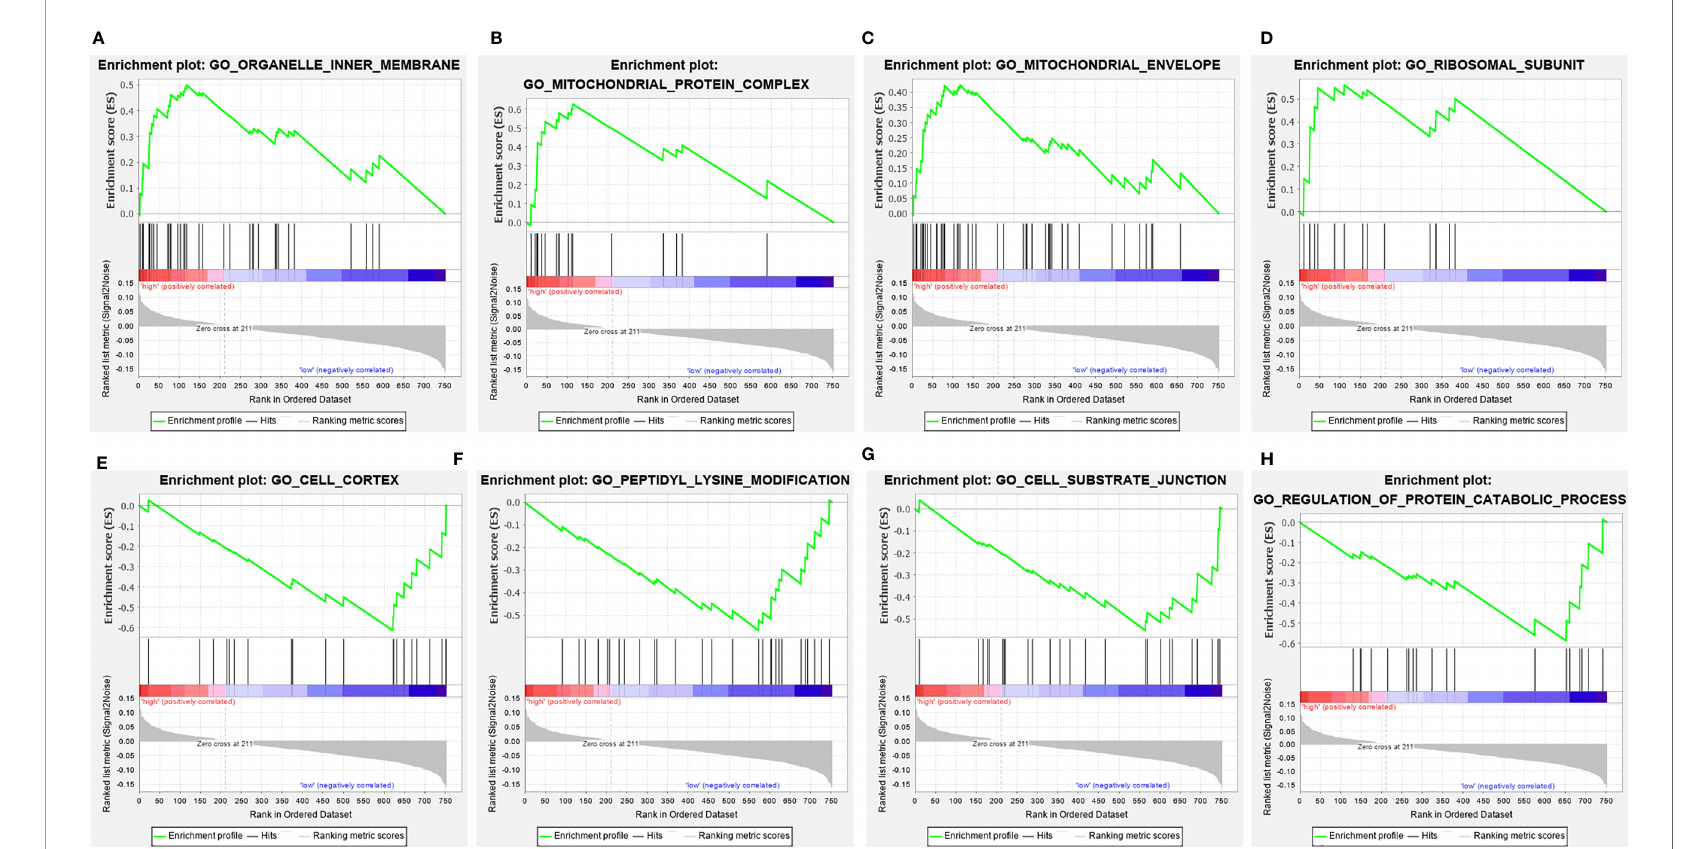
FIGURE 9 | Gene set enrichment analysis of genes in high-risk and low-risk patients in THCA. (A – D) Gene set enrichment analysis (GSEA) showing the enrichment of hallmarks in high-risk patients with THCA. (E – H) GSEA showing the enrichment of hallmarks in low-risk patients with